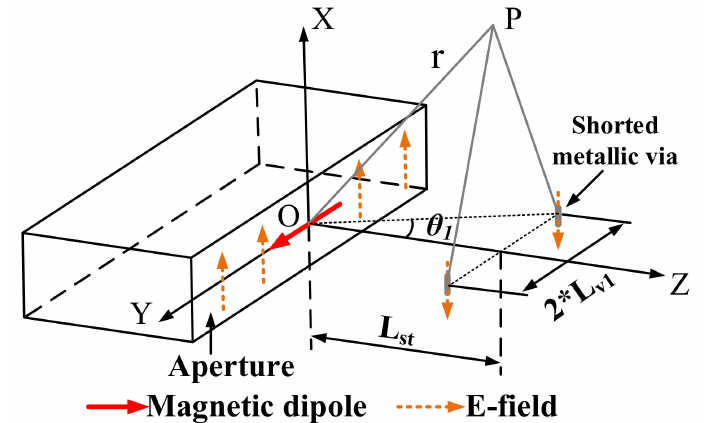
Figure 7. The equivalent source’s model for the SIW-fed folded dipole